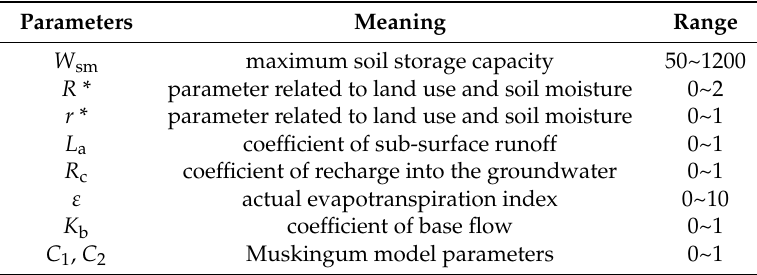
Table A1. Model parameters and